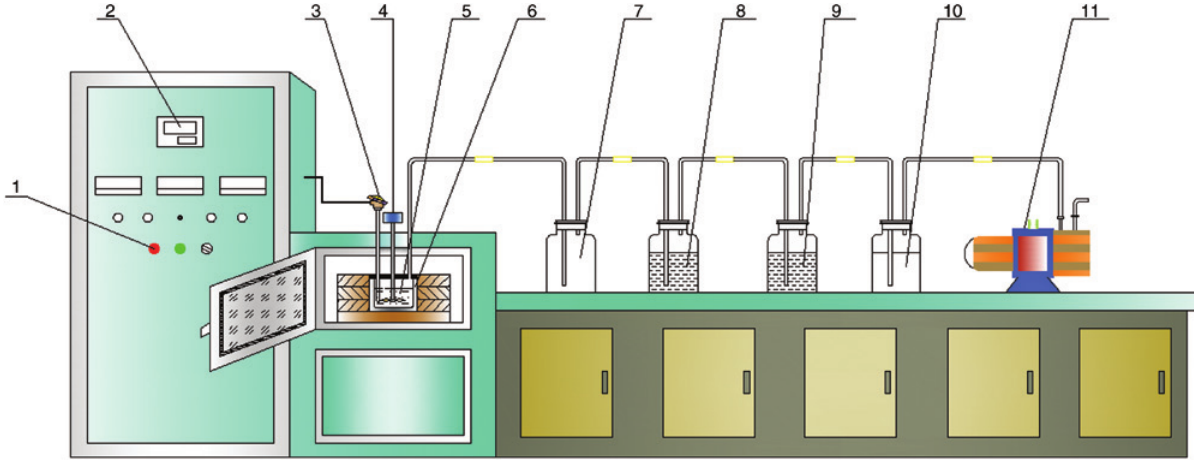
Figure 5: Experiment equipment for microwave roasting. 1-the control system of microwave; 2-temperature display; 3-thermocouple; 4-blender; 5-zinc oxide dust sample; 6-mullite crucible; 7-dust collection bottle; 8-a water-absorption bottle; 9-alkali-absorption bottle; 10-buffer bottle; 11-miniature pump.